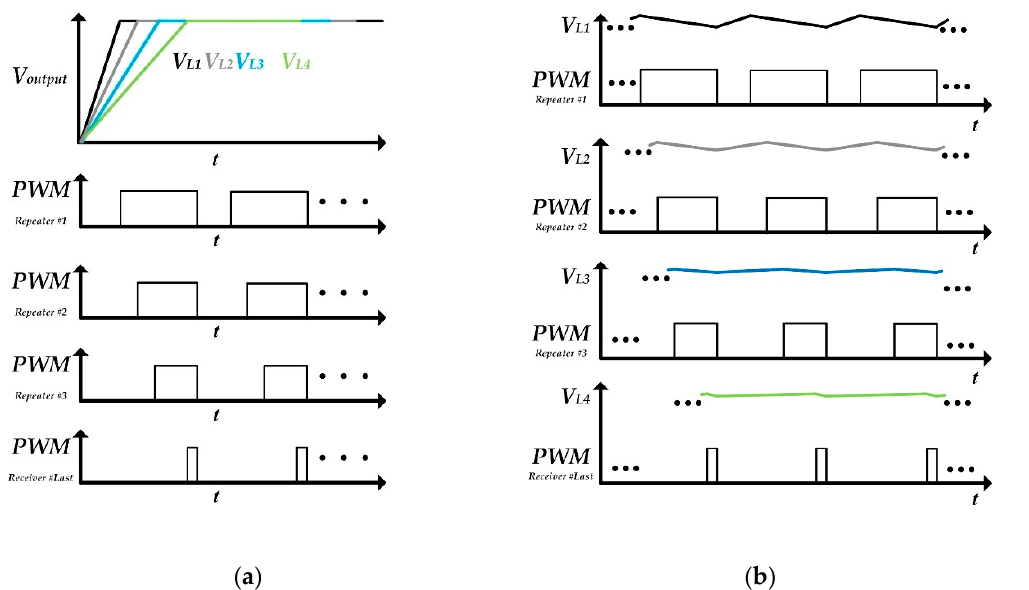
Figure 6. Sequential turn on of repeaters and last receiver switches at respective output voltages ( a ) power regulation ( b ).